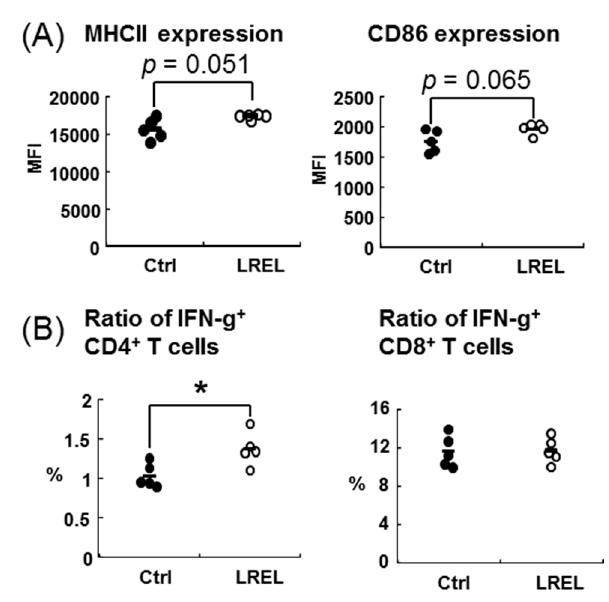
Figure 4. Activation of mucosal acquired immune system by LREL oral treatment for two weeks. Healthy C57BL/6J mice were divided into control and LREL groups ( n = 5 in each group); mice in the LREL group received oral administration AIN93G containing 10 mg/day of LREL and mice in the control group received oral administration of AIN93G without LREL for two weeks. ( A ) Comparison of cell surface activation marker expression on MLN mDCs between the control and LREL group. Expression levels of MHC class II (left panel) and CD86 (right panel) were analyzed by flow cytometry (expressed as MFI) and mDCs were defined as “CD11c + CD11b + PDCA-1 − ” in low density cells. MLN mDCs tended to be activated by LREL oral treatment for 2 weeks. ( B ) Ratios of IFN- γ producing T cells in MLN were analyzed by flow cytometry. T cells were defined as “CD3 ε + NK1.1 − “. Ratio of IFN- γ producing CD4 + T cells (left panel) was significantly increased in the LREL group, while that of CD8 + T cells (right panel) was not changed. The short line in all figures represents the mean value ( n = 5). *, p < 0.05 compared to control (Student’s t test). These data are representative of two independent experiments.